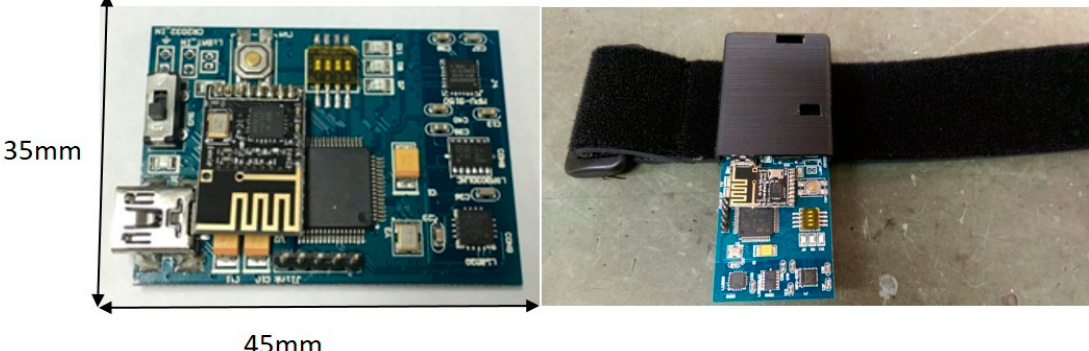
Figure 3. Top view of sensor nodes ( Left ); the wearable sensor node ( Right ).